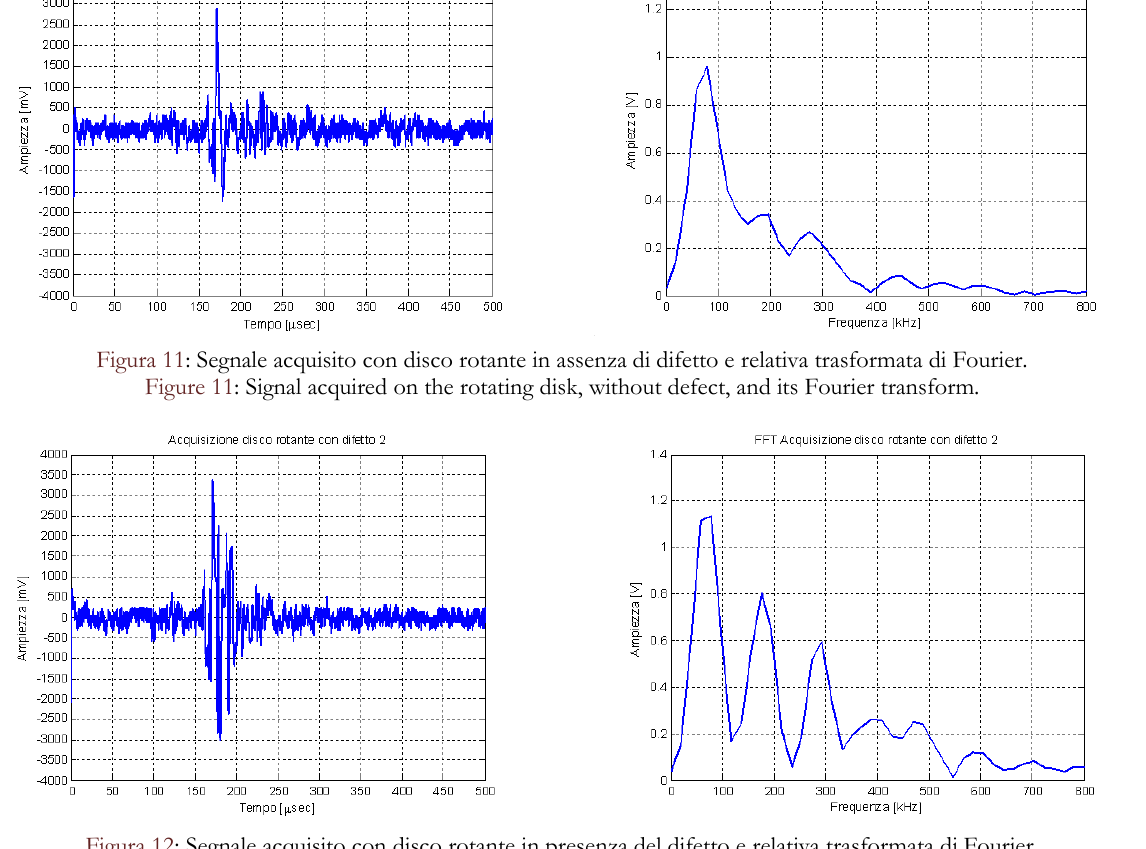
Figura 12: Segnale acquisito con disco rotante in presenza del difetto e relativa trasformata di Fourier. Figure 12: Signal acquired on the rotating disk, with defect, and its Fourier